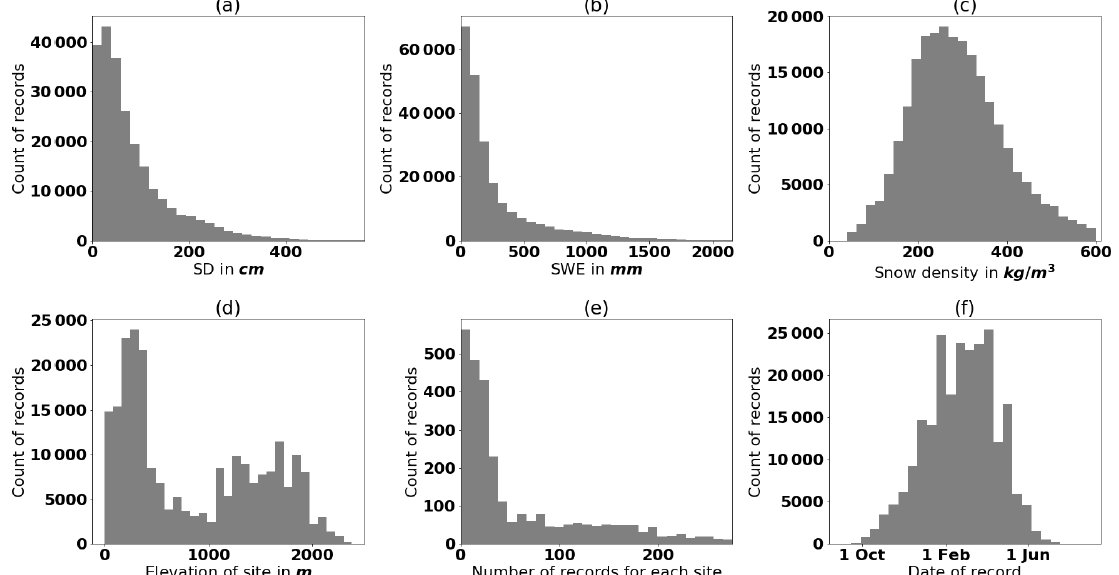
Figure 3. Distribution of the records in the Canadian historical snow survey (CHSS) data set for (a) snow depth, (b) SWE, (c) snow density, (d) elevation, and (f) the date of the record; the year starts on 1 September to cover the Northern Hemisphere winter season over 2 calendar years. (e) Distribution of number of records for each site; upper outliers (0.1%) are excluded in panels (a) , (b) , and (c) . Furthermore, the upper 2.5% of stations are not shown in panel (e) . The maximum in panel (e) is at 3203 and the mean at about 82 records for each station.